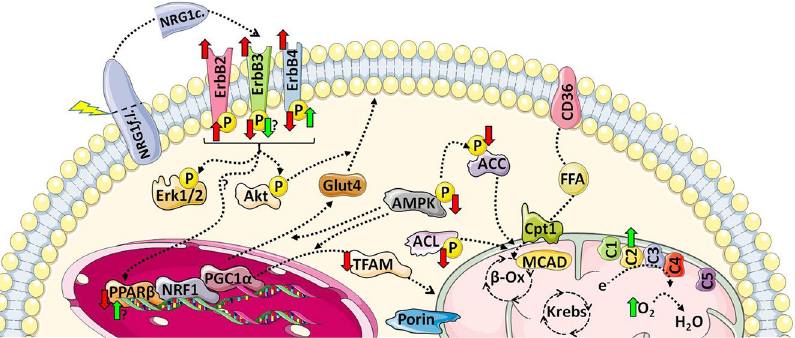
Figure 4. Summary of the main effects of diabetes and NRG1 treatment in gastrocnemius muscle. The abundance of ERBB receptors is increased in diabetic db/db mice. This is associated with increased phosphorylation ratio of ERBB2 and decreased phosphorylation ratios of ERBB3 and ERBB4. Similarly, phosphorylation (activation) of the metabolic regulators AMPK, ACC and ACL is reduced in diabetic mice as well as Pparb and Tfam mRNA expression level. However, mitochondrial respiration in permeabilised fibres is similar in diabetic and control healthy mice. Chronic NRG1 treatment increases ERBB4 phosphorylation and tends to decrease ERBB3 phosphorylation. Among the regulators of the mitochondrial biogenesis pathway, only Pparb mRNA expression is slightly increased by NRG1. However, in NRG1-treated mice, complex 2-mediated mitochondrial respiration and complex 2 subunit abundance are increased. Effect of diabetes: red arrows. Effect of NRG1: green arrows. Figure was produced using Servier Medical Art image bank (http://www.servier.com/ Powerpoint-image-bank), which is licensed under a Creative Commons Attribution 3.0 Unported License